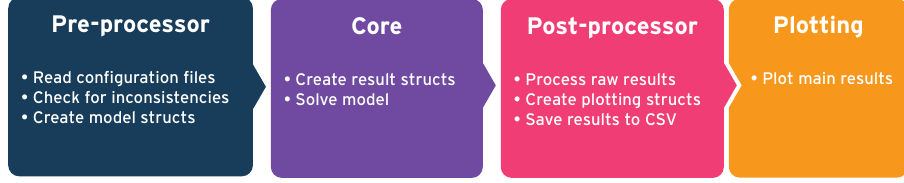
Figure 1. Four steps of